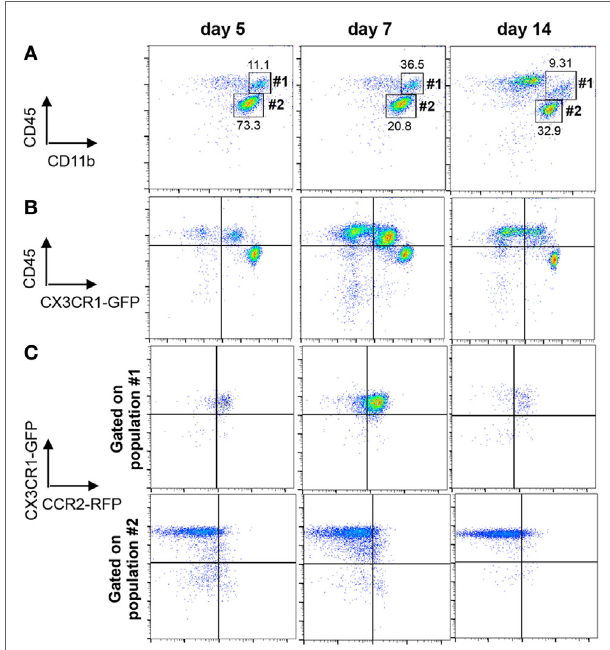
FigUre 2 | Distinction of microglia and infiltrating bone marrow-derived macrophage (BMDM) within the central nervous system (CNS) of CX3CR1 GFP/ + CCR2 RFP/ + mice. (a) Representative flow cytometry plots of CD45 hi CD11b + BMDM (population #1) and CD45 low CD11b + microglia (population #2) gated on total CD45 cells from JHMV-infected spinal cords at the indicated time points. (B) Cells from Panel A were analyzed for differential CX3CR1 GFP expression on CD45 hi and CD45 low populations. (c) Cells from Panel A gated on CD45 hi CD11b + BMDM (population 1) or CD45 low CD11b + microglia (population #2) were assessed for CX3CR1 GFP and CCR2 RFP expression. All data are acquired from mechanically disrupted tissue of JHMV-infected CX3CR1 GFP/ + CCR2 RFP/ + mice and representative of two separate experiments with at least three mice per time point per